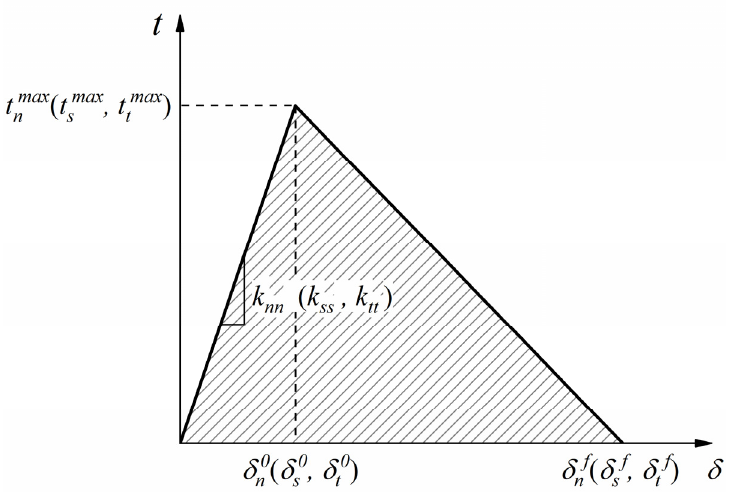
Figure 6. Traction separation model [30].